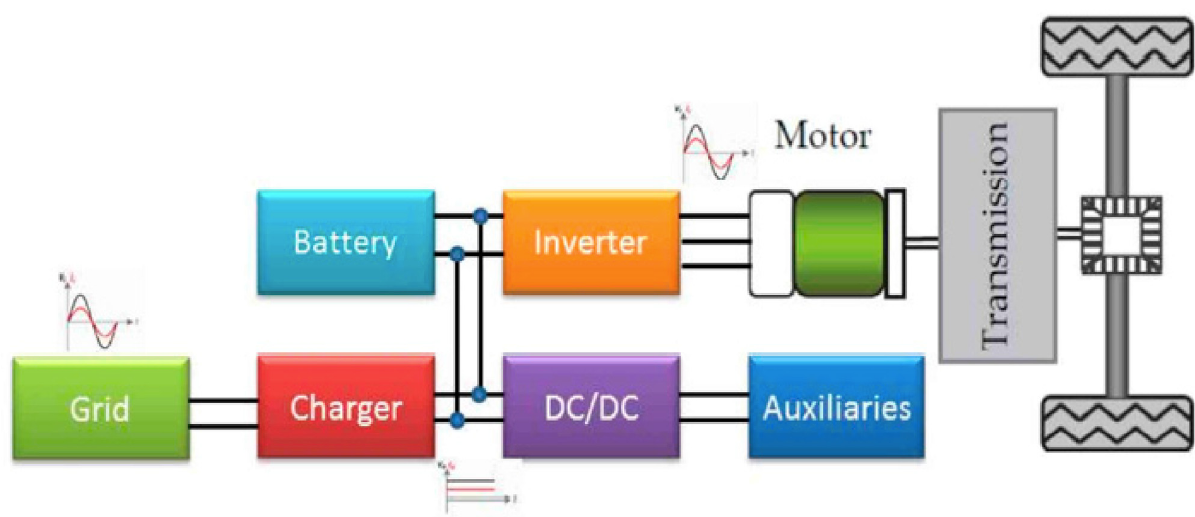
Figure 1. Electric car powertrain